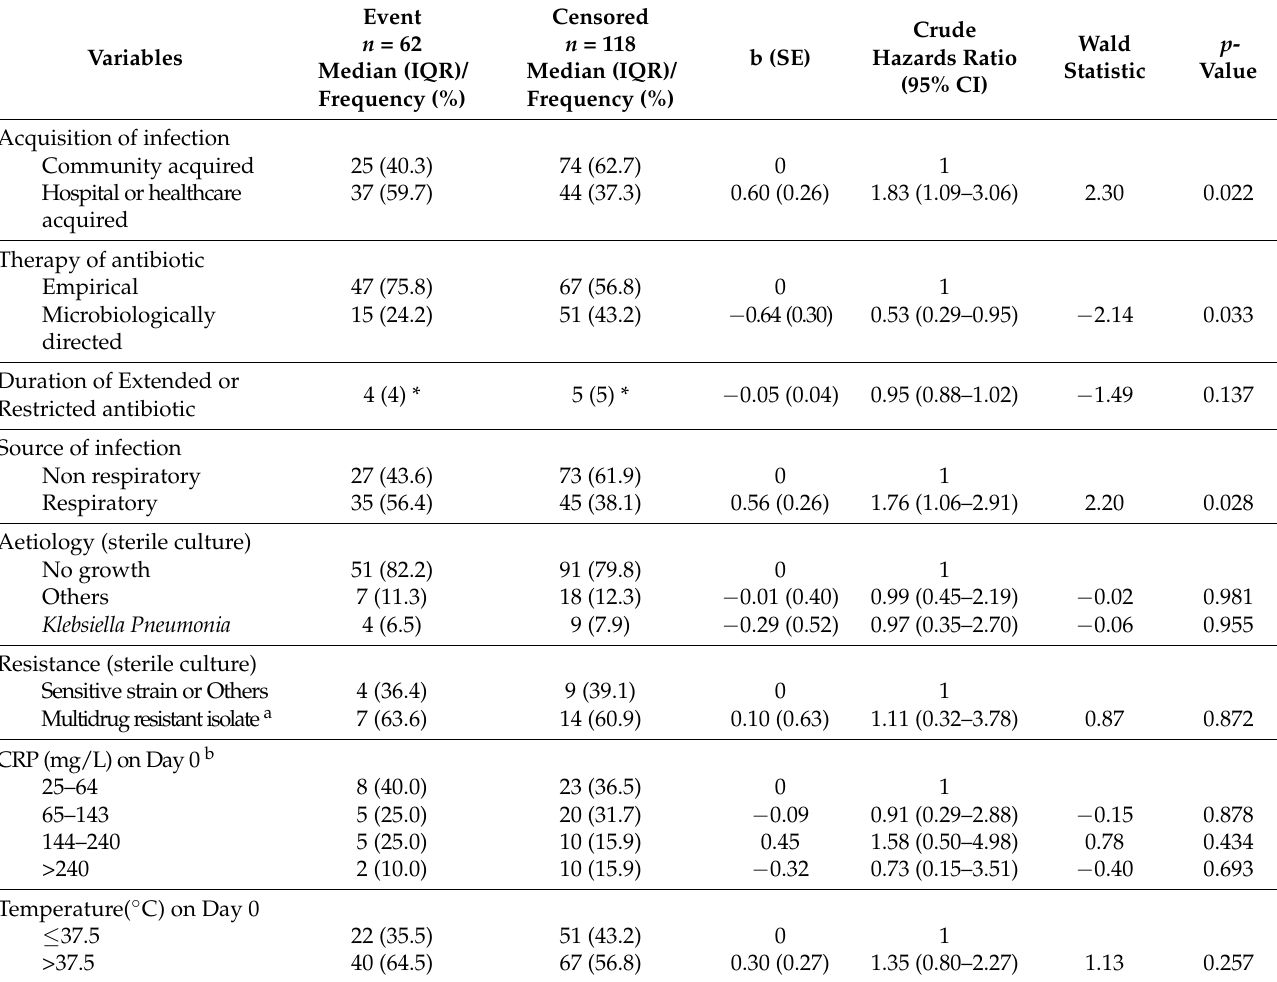
Table 5. Clinical related factor of all-cause 30-days mortality in patients suspected with bacterial infection on extended or restricted antibiotic using simple Cox proportional hazards regression model ( n =